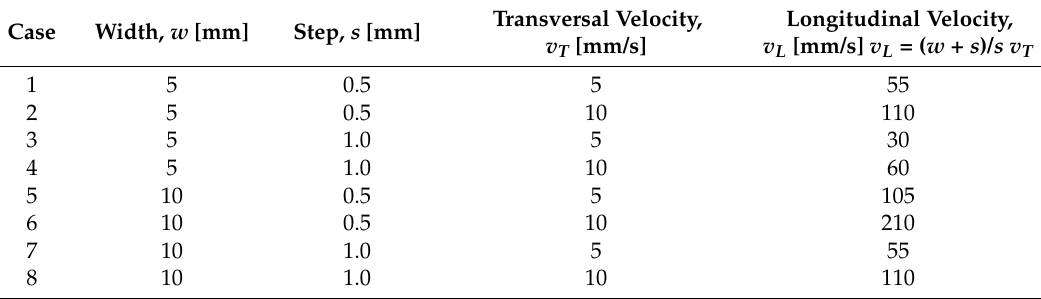
Figure 2. Single S-shape scanning path: experimental setup. Table 1. Single S-shape scanning path: studied